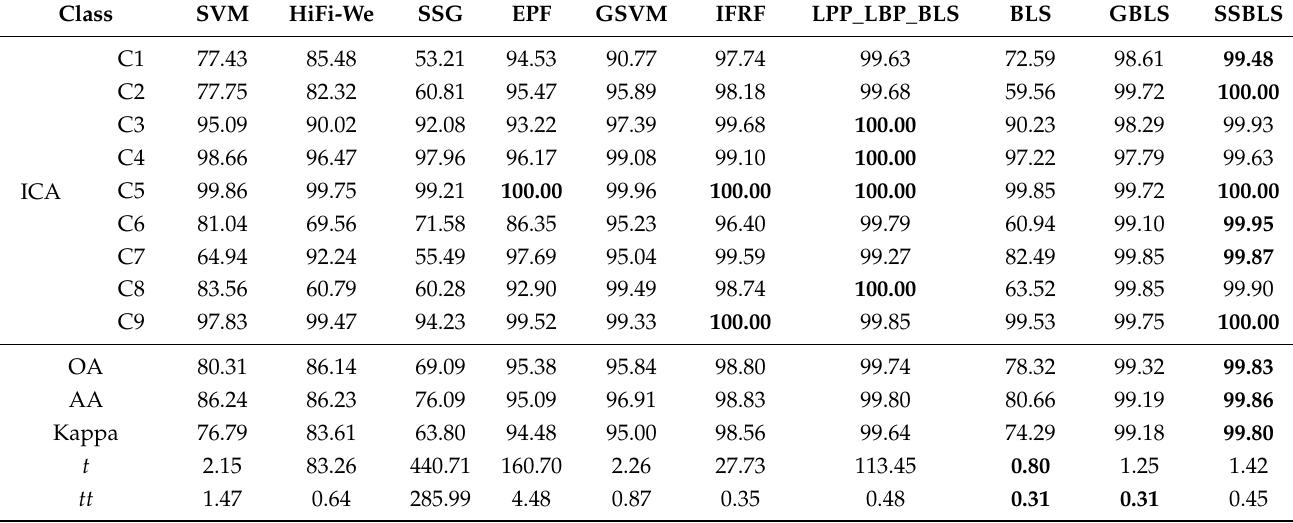
Table 3. Classification results of all comparison methods on the Indian Pines dataset in term of individual classification